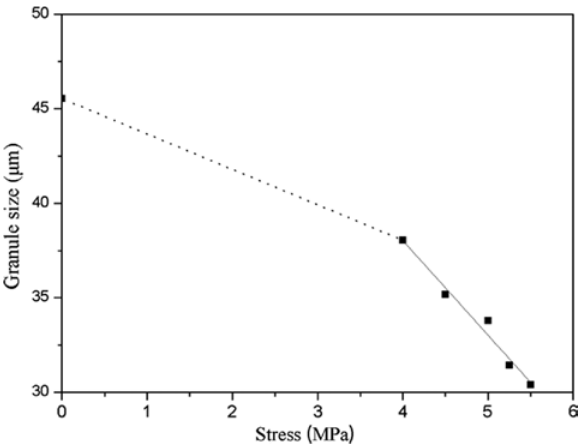
Figure 9: Dependence of average particle size on applied